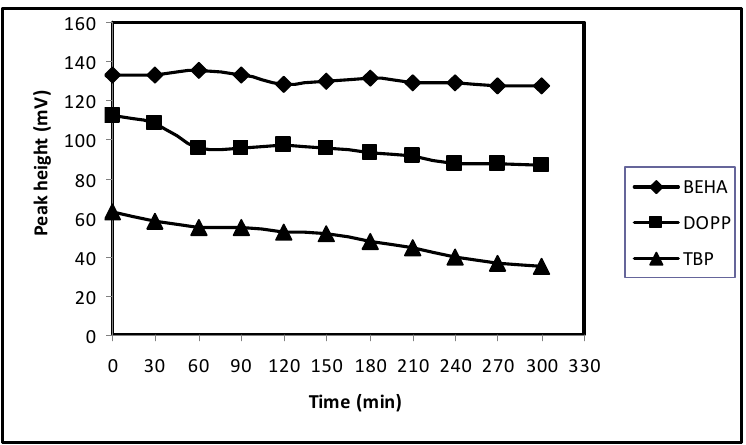
Figure 5. Lifetime studies of promethazine sensors based on β -CD with different plasticizer (sensors 10, 13 and 16). Peak heights from the injection of promethazine standards at regular interval were noted when continuously pumped with carrier stream.